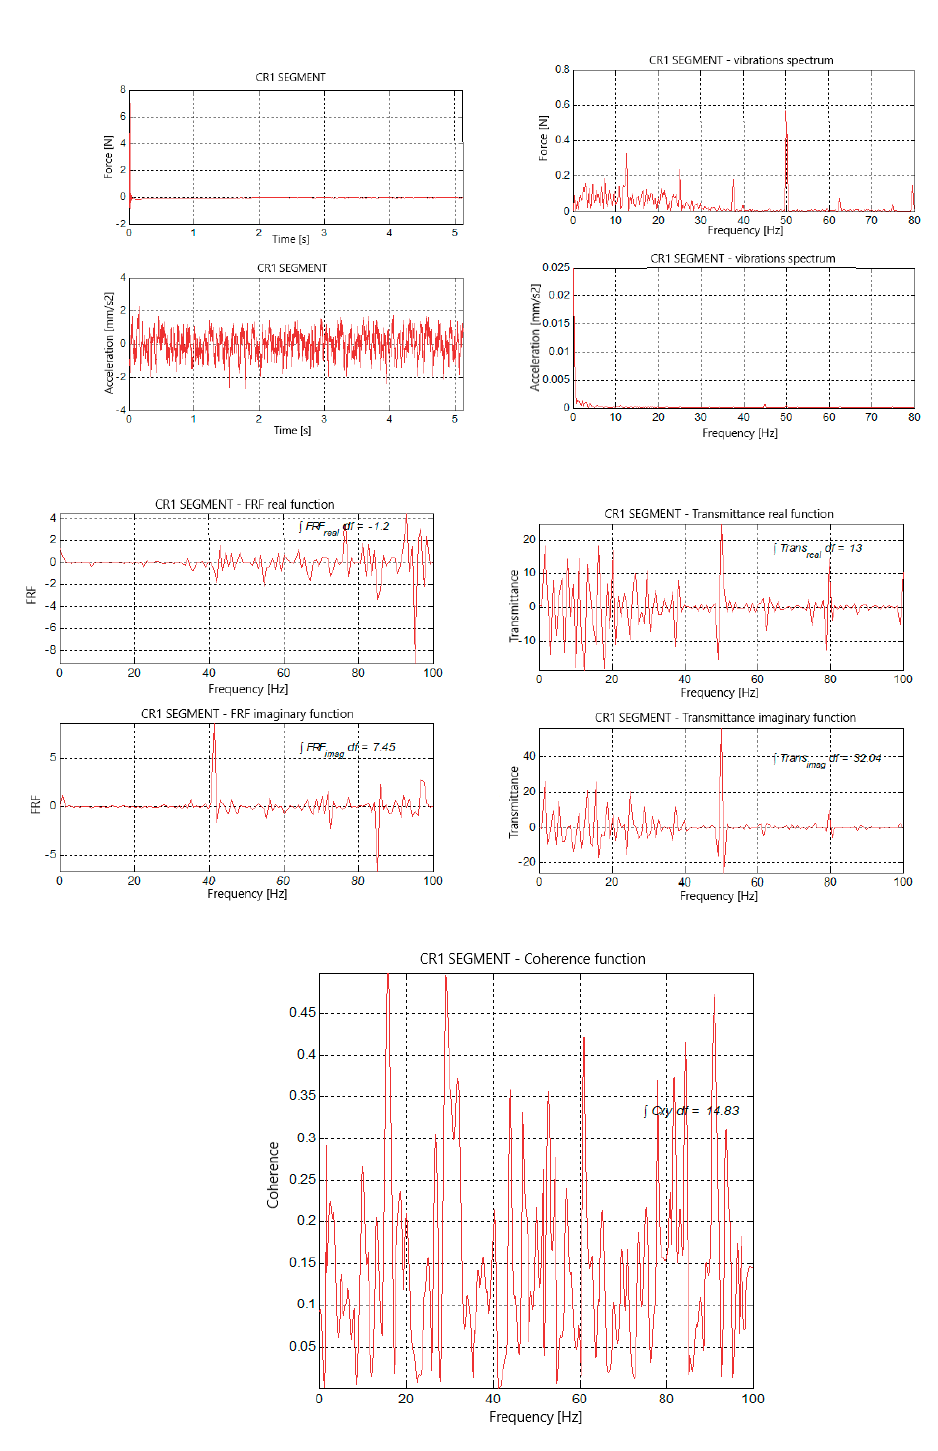
Figure 11. Vibration measures results for CR1 segments.